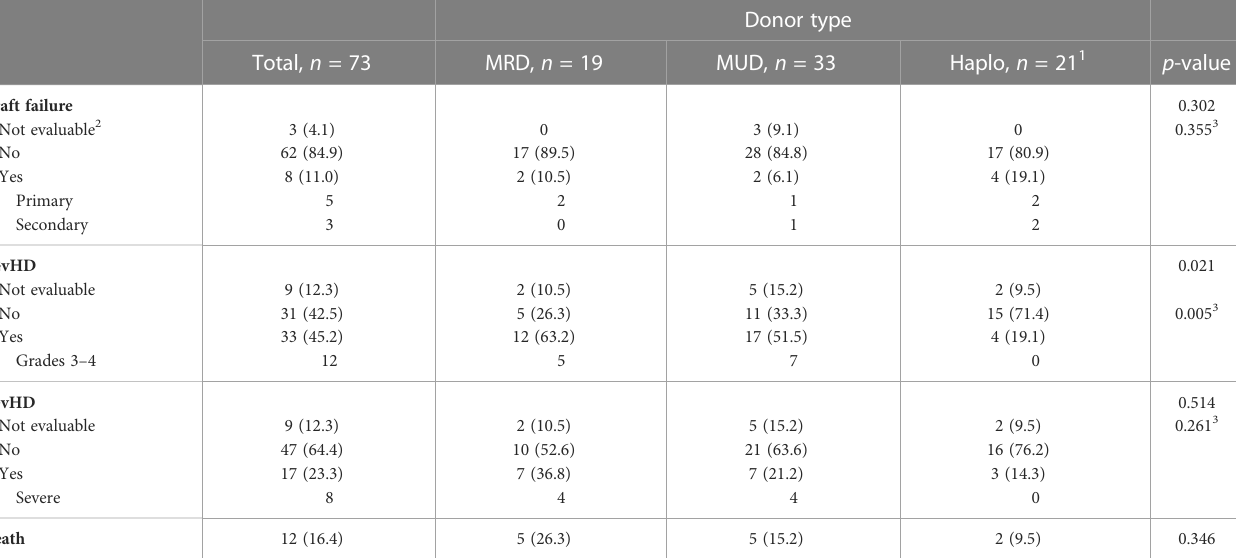
TABLE 3 Outcomes of the 73 HSCTs according to donor